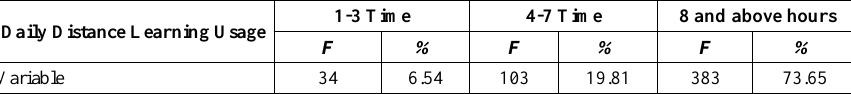
Table 3. Daily distance education usage period of university students